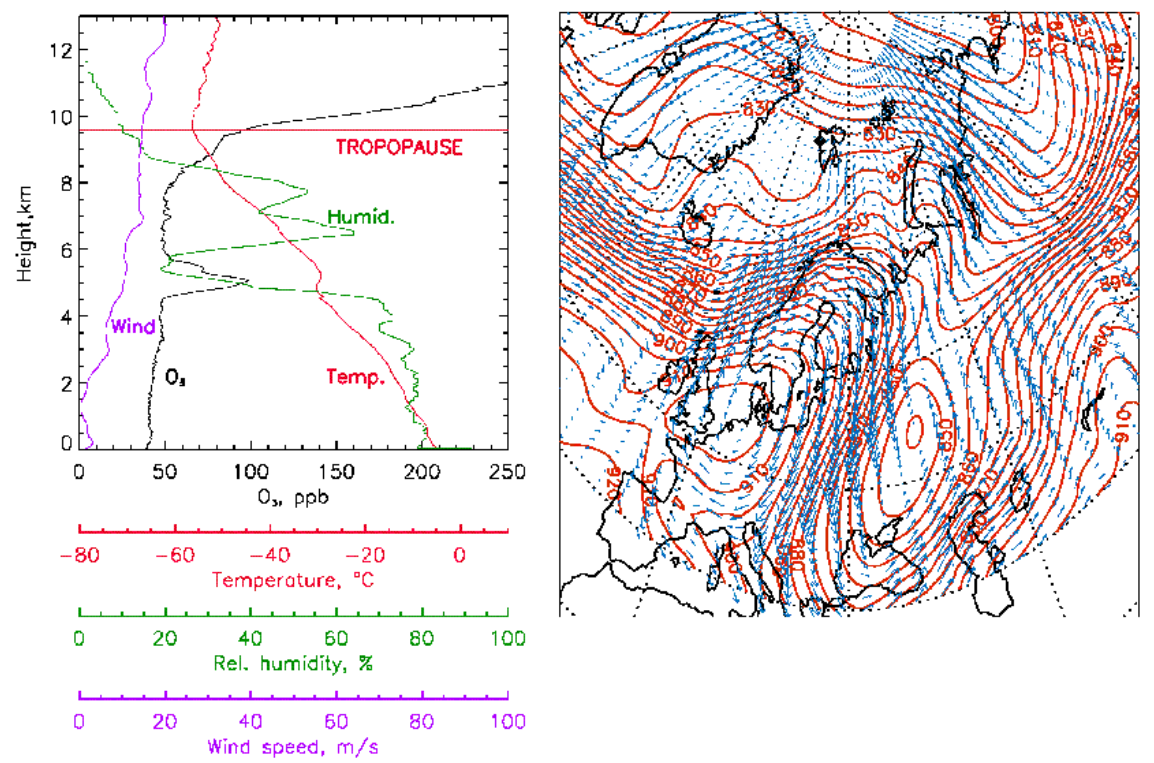
Fig. 8. Same as in Fig. 1 but at Ny- ˚Alesund at 12:00UTC on 27 November